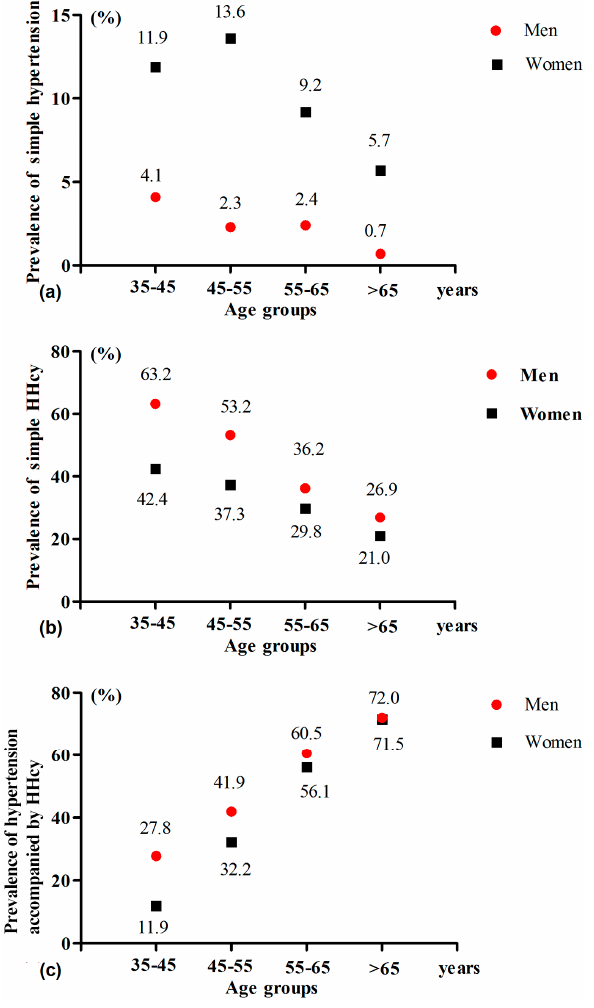
Figure 2. The prevalence of simple hypertension ( a ) simple HHcy ( b ) and hypertension accompanied by HHcy ( c ) in four age groups classified by gender. HHcy: high homocysteine